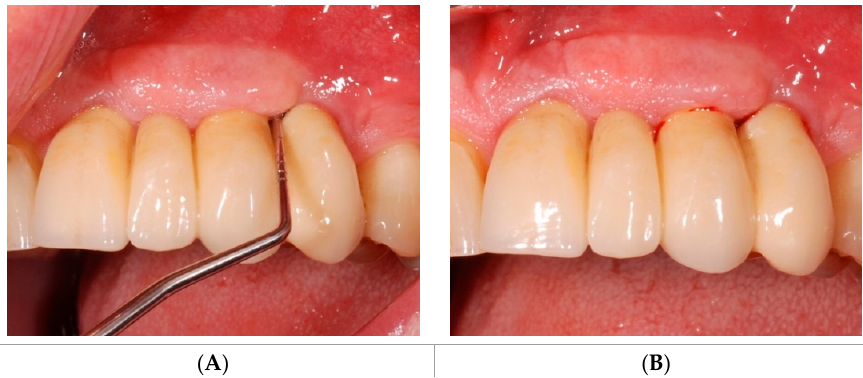
Figure 9. Clinical follow-up at T1: decreased PPD ( A ) and BOP ( B ) at the Qualifying site.